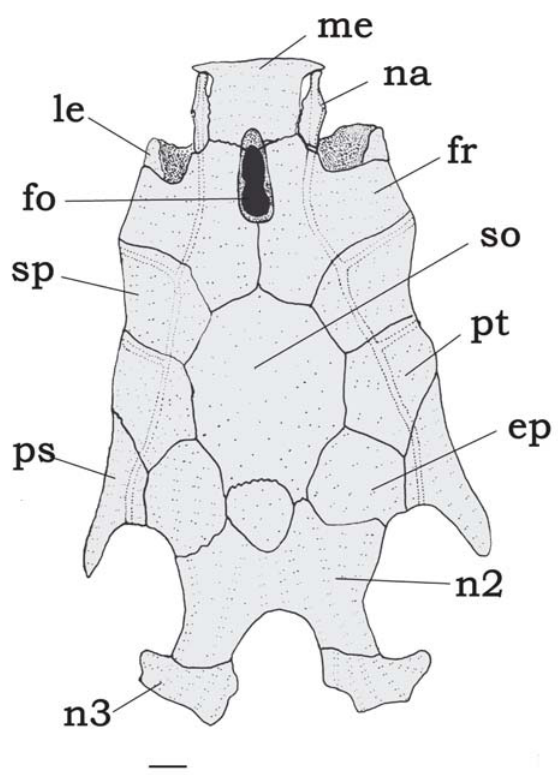
Fig. 11. Neurocranium of Tatia boemia , MCP 12949, paratype, 59.9 mm SL. Dorsal view. Abbreviations: ep , epioccipital; fo , single cranial fontanel; fr , frontal; le , lateral ethmoid; me , mesethmoid; na , nasal; n2 ; second nuchal plate; n3 , third nuchal plate; ps , posttemporal-supracleithrum; pt , pterotic; so , supraoccipital; sp , sphenotic. Scale bar = 1.0